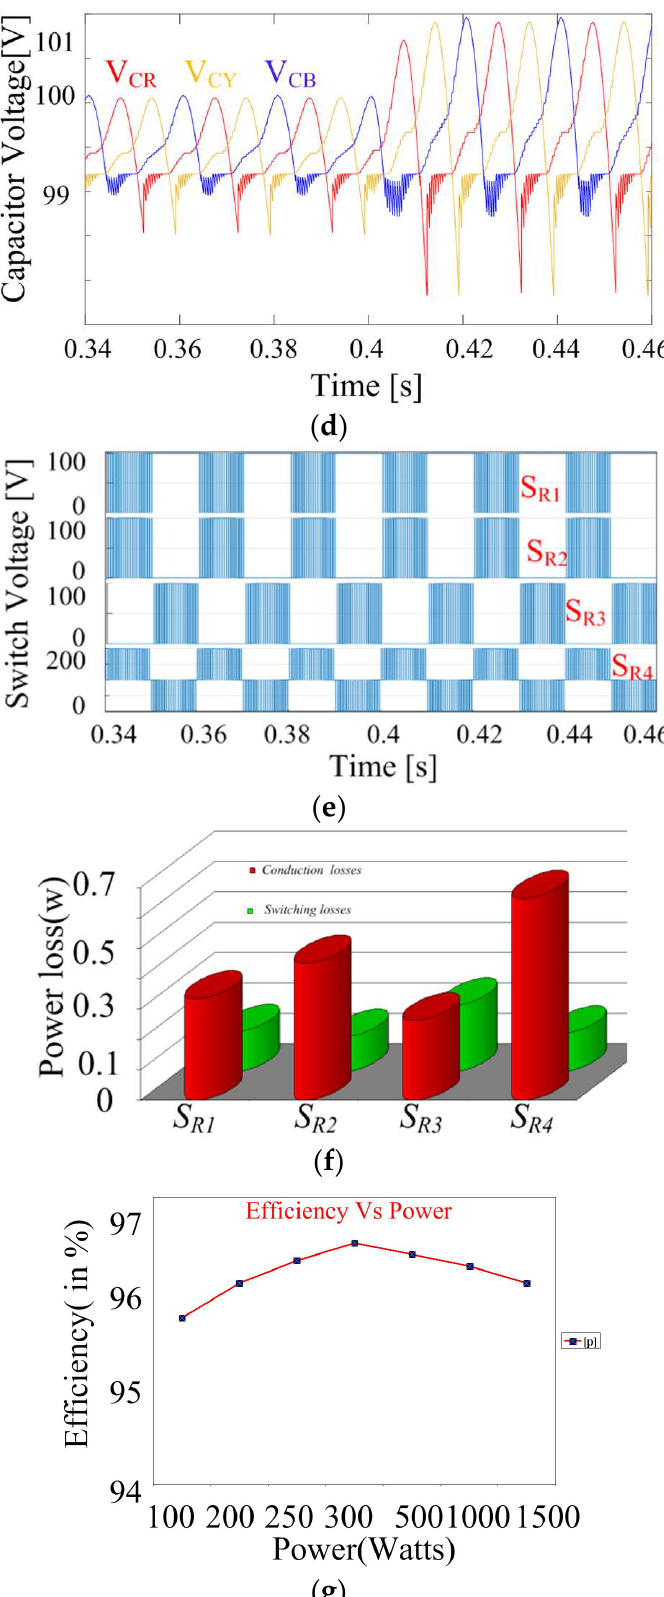
Figure 5. Simulated results. ( a ) Pole voltage; ( b ) Line voltage; ( c ) Line current; ( d ) Voltage across capacitors; ( e ) Voltage stress of switches; ( f ) Per phase distribution of power losses; ( g ) Power versus efficiency curve.